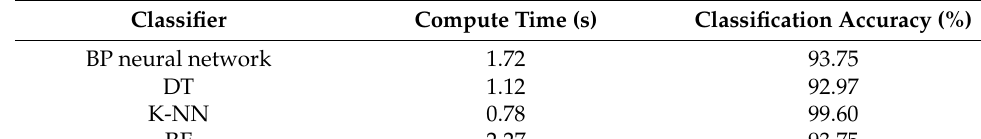
Table 4. Comparison of computing time and classification accuracy.